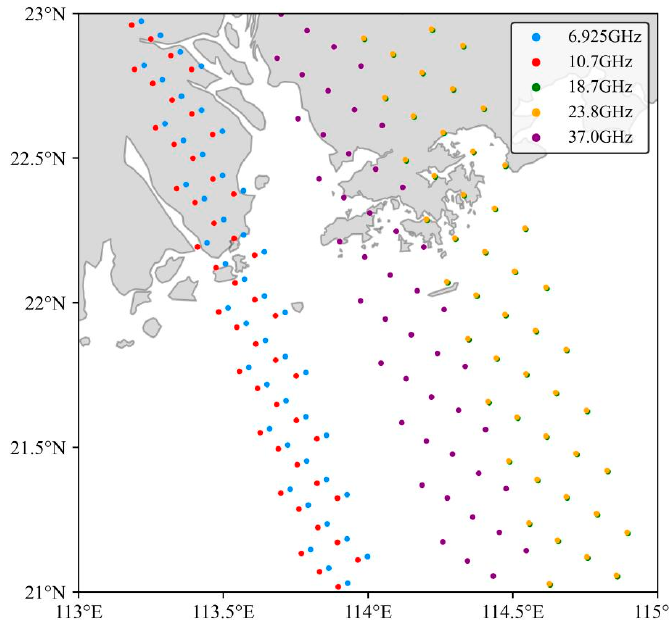
Remote Sens. 2023 , 15 , 889 Figure 4. The spatial distribution of the HY-2B SMR’s first 5 pixels between different frequency channels. Table 3. Threshold of CLWP and available pixels after resampling to 6.925 GHz.